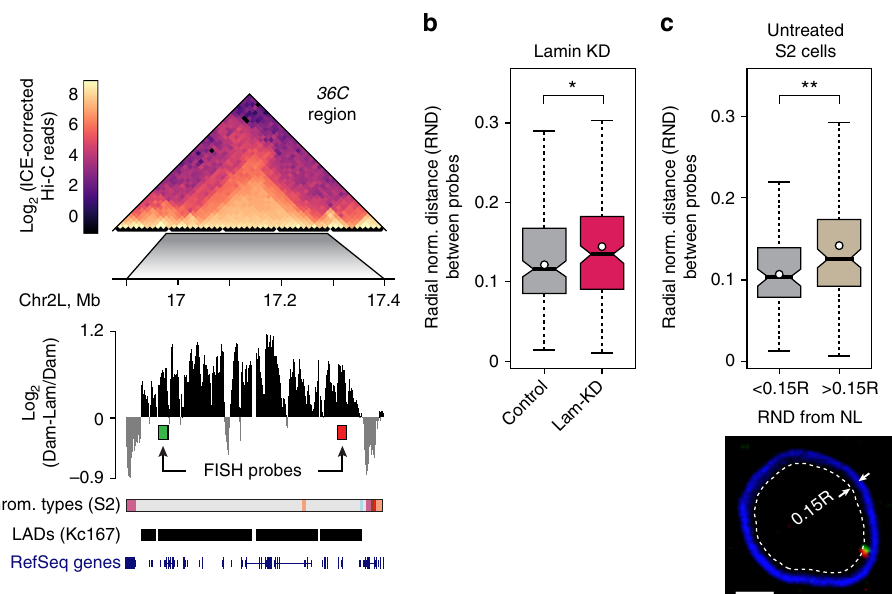
Fig. 5 Chromatin density is decreased in a TAD following its detachment from the NE. a Genomic region 36C carrying probes for two-colour FISH analysis. The Hi-C map from untreated S2 cells, lamin – DamID pro fi le from Kc167 cells 5 , the occupancy of 9 chromatin types from S2 cells 40 , LAD annotation from Kc167 cells 28 , and RefSeq gene positions are shown. b Radial-normalised distance (RND) between two FISH probes in Lam-KD ( n = 175) and control ( n = 175) S2 cells. * P < 0.05 in a Kolmogorov-Smirnov one-sided test. c RND between two FISH probes in the untreated S2 cells. RND < 0.15, n = 84, RND > 0.15, n = 124. ** P < 0.01 in a Kolmogorov-Smirnov one-sided test. A representative example of two-colour FISH signals (red and green) in a nucleus stained with anti-LBR antibody is shown below. Nuclear shell of 0.15 R width (R nuclear radius) where the signals are in visible contact with the NL is outlined by the dotted line. Scale bar 1 µ m. See Fig. 1g legend for description of boxplot elements represented on panels ( b , c